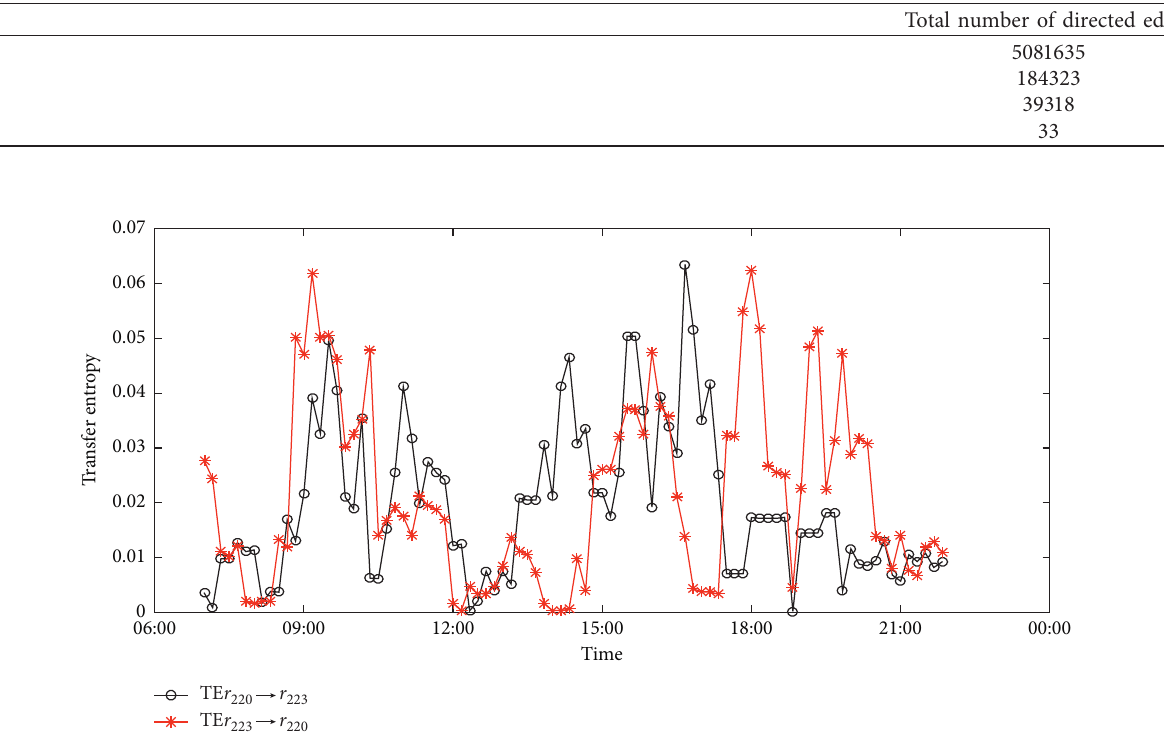
Figure 7: Variation of transfer entropy in different directions.